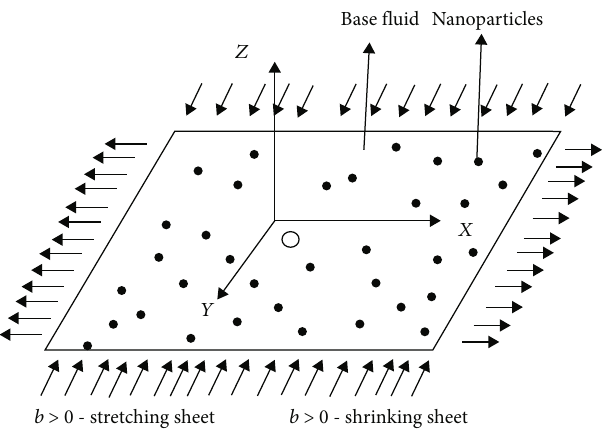
Figure 1: Physical con fi guration of the proposed